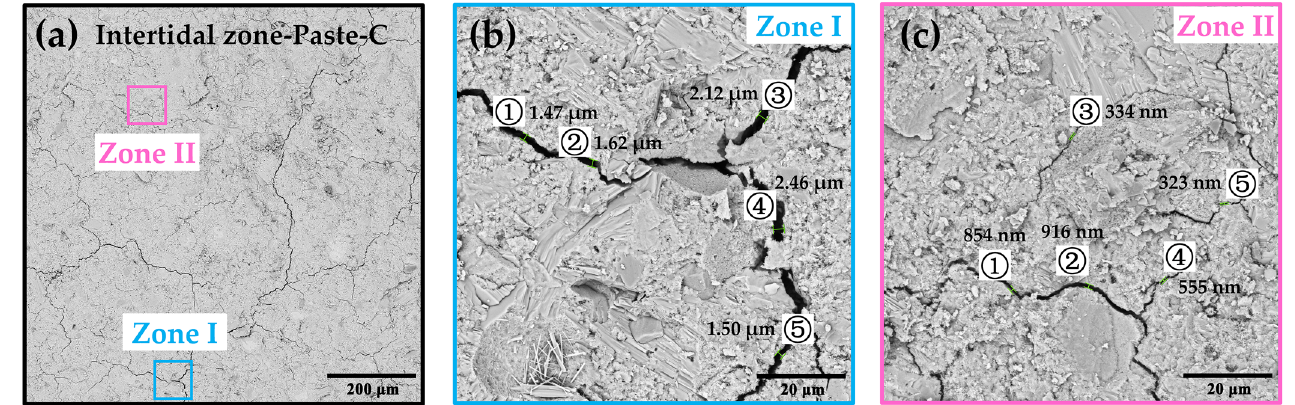
Figure 9. The SEM photos of internal cracks in Intertidal zone-Paste-C at ( a ) 300 magnification and ( b , c ) 3,000 magnification.